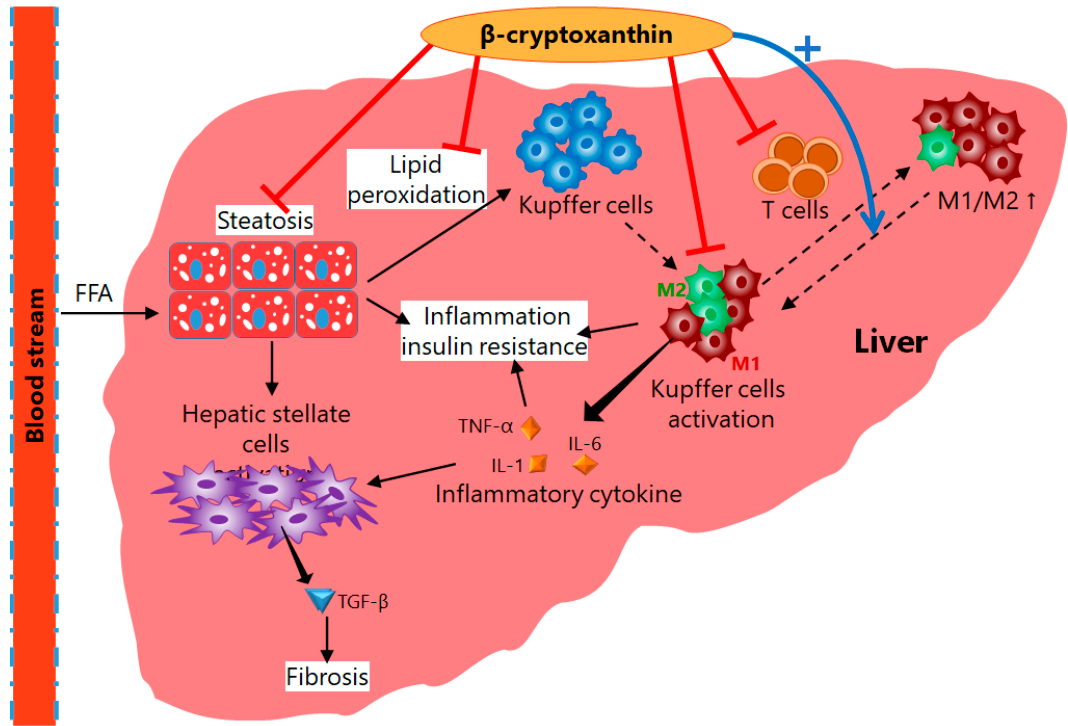
Figure 5. Control mechanism of dietary β -cryptoxanthin against progression of NAFLD: β -Cryptoxanthin inhibits not only lipid accumulation but also acts as an antioxidant and suppresses lipid peroxidation and inflammation, and thus results in improved insulin resistance in the liver. Additionally, β -cryptoxanthin prevents Kupffer cell activation by changing the M1/M2 status to M2 predominant. Consequently, β -cryptoxanthin controls progression of NAFLD by various biological and defensive activities.